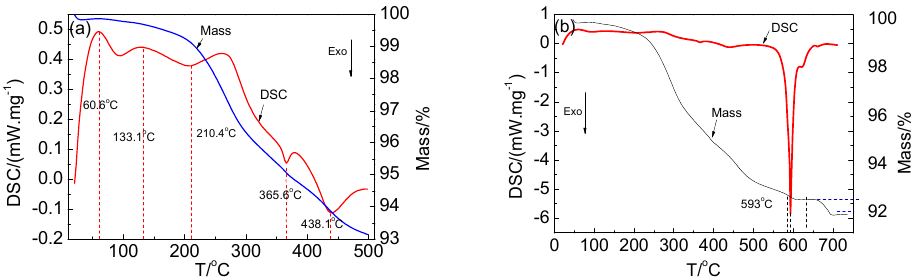
and the layered structure was destroyed.